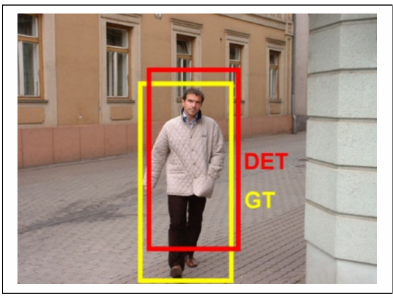
Figure 20. Ground-truth bounding box and detected bounding box.